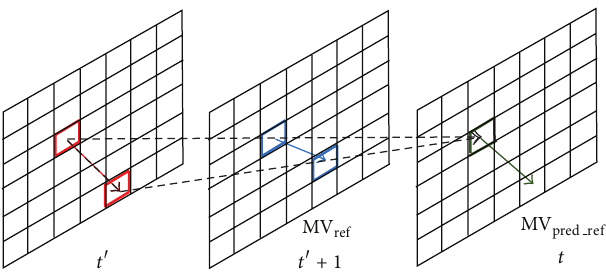
Figure 11: Neighboring reference frame prediction.